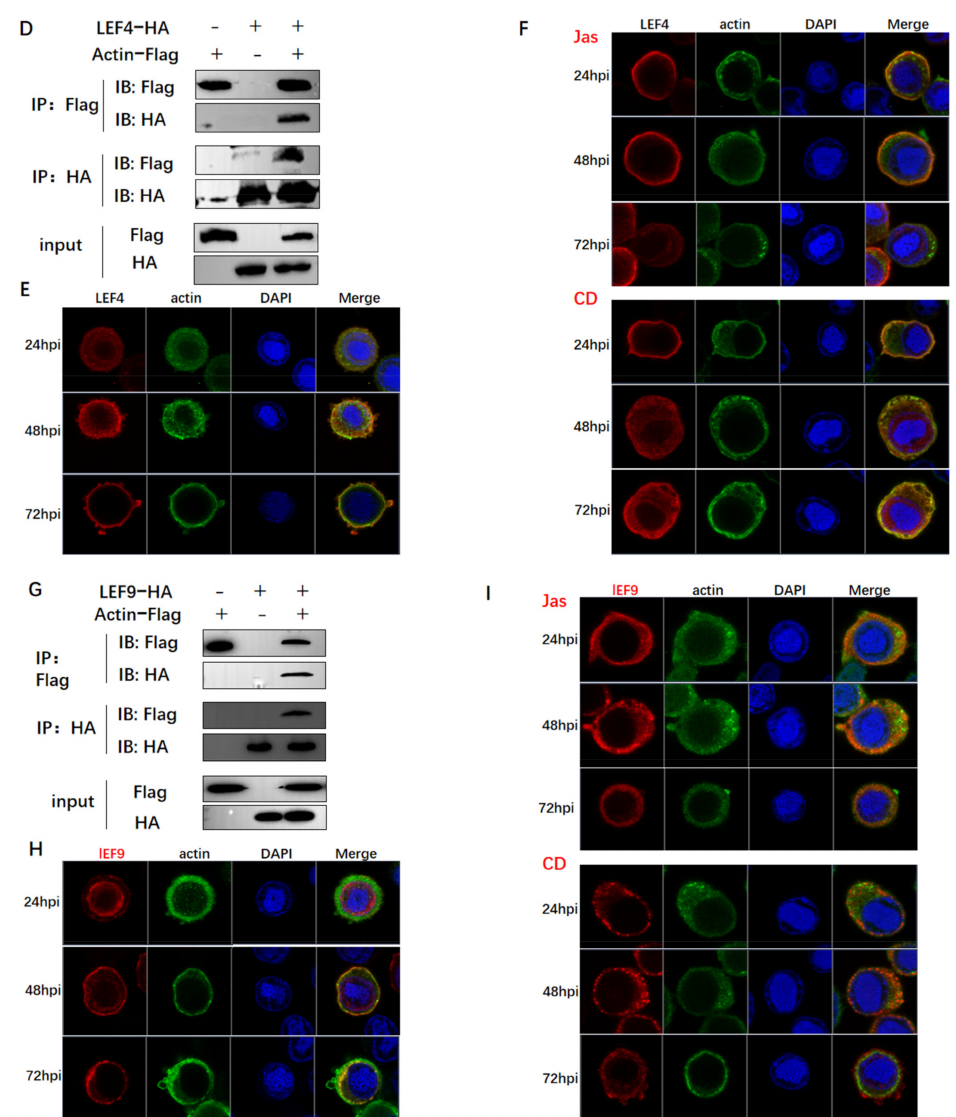
Figure 3. The analysis of the relationship between actin and viral polymerase. ( A , D , G ) Co-IP assays used to confirm interactions of actin with P47, LEF4, and LEF9. BmN cells coinfected with recombinant viruses vBm-actin-Flag and vBm-P47-HA, vBm-LEF4-HA, and vBm-LEF9-HA were lysed at 72 h p.i. and the proteins were immunoprecipitated with anti-Flag or anti-HA monoclonal antibody. The precipitates (Co-IP) were detected by Western blots with anti-Flag and anti-HA monoclonal antibody. The cell lysates (lysate input) were also examined by Western blots with an anti-HA rabbit polyclonal antibody or an anti-Flag rabbit monoclonal antibody. ( B , E , H ) Co-localization analysis of actin with P47, LEF4, and LEF9 by confocal microscopy. At the designated time points, BmN cells coinfected with recombinant viruses vBm-actin-Flag and vBm-P47-HA, vBm-LEF4-HA, and vBm-LEF9-HA were fixed, permeabilized, blocked, and incubated with rabbit anti-Flag antibody and mouse anti-HA antibody, followed by treatment with Alexa Fluor 546–conjugated goat anti-rabbit IgG and Alexa Fluor 488–conjugated goat anti-mouse IgG. ( C , F , I ) As in ( B , E , H ), at 15 h p.i., cells were treated with CD or Jas and then subjected to confocal